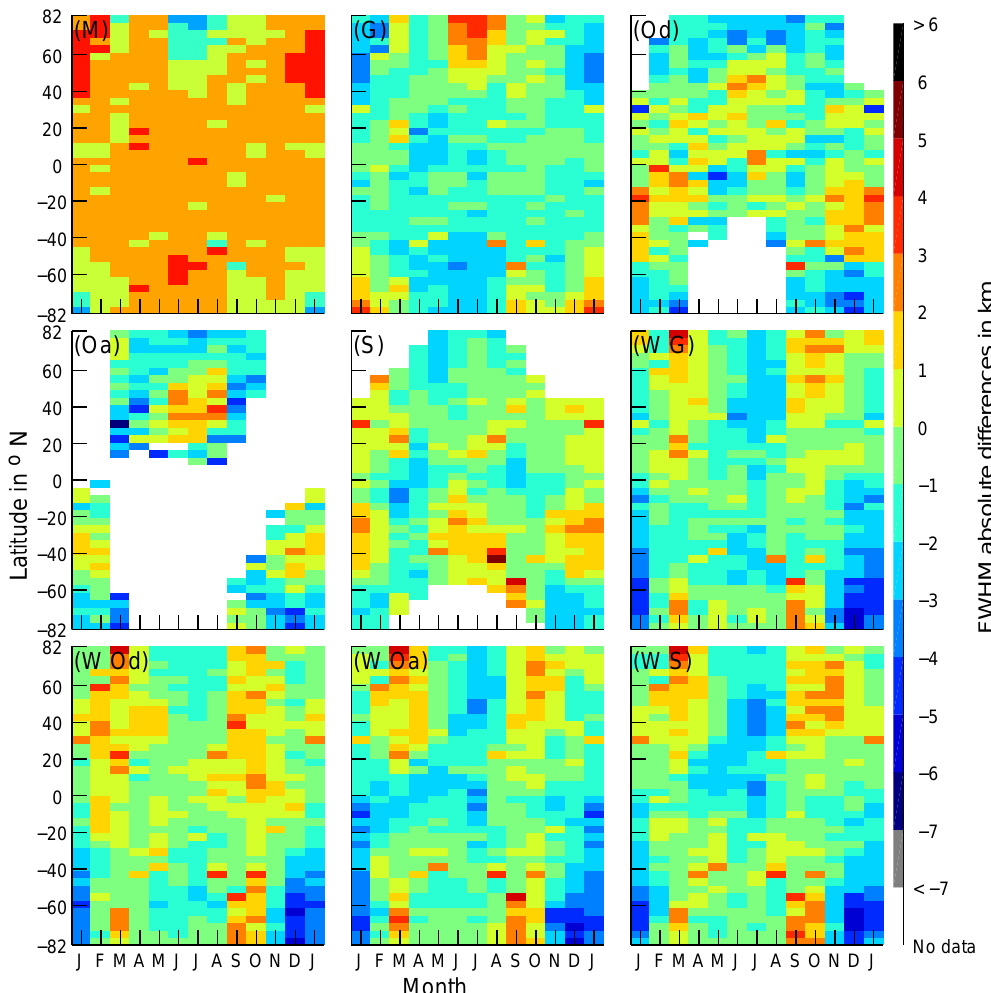
Figure 9. Absolute full width at half maximum differences of the individual instrument/model results compared to the ensemble mean. The panels are for the same results as in Fig. 8. The upper left panel shows the ensemble mean with the same color bar as in Fig. 8.